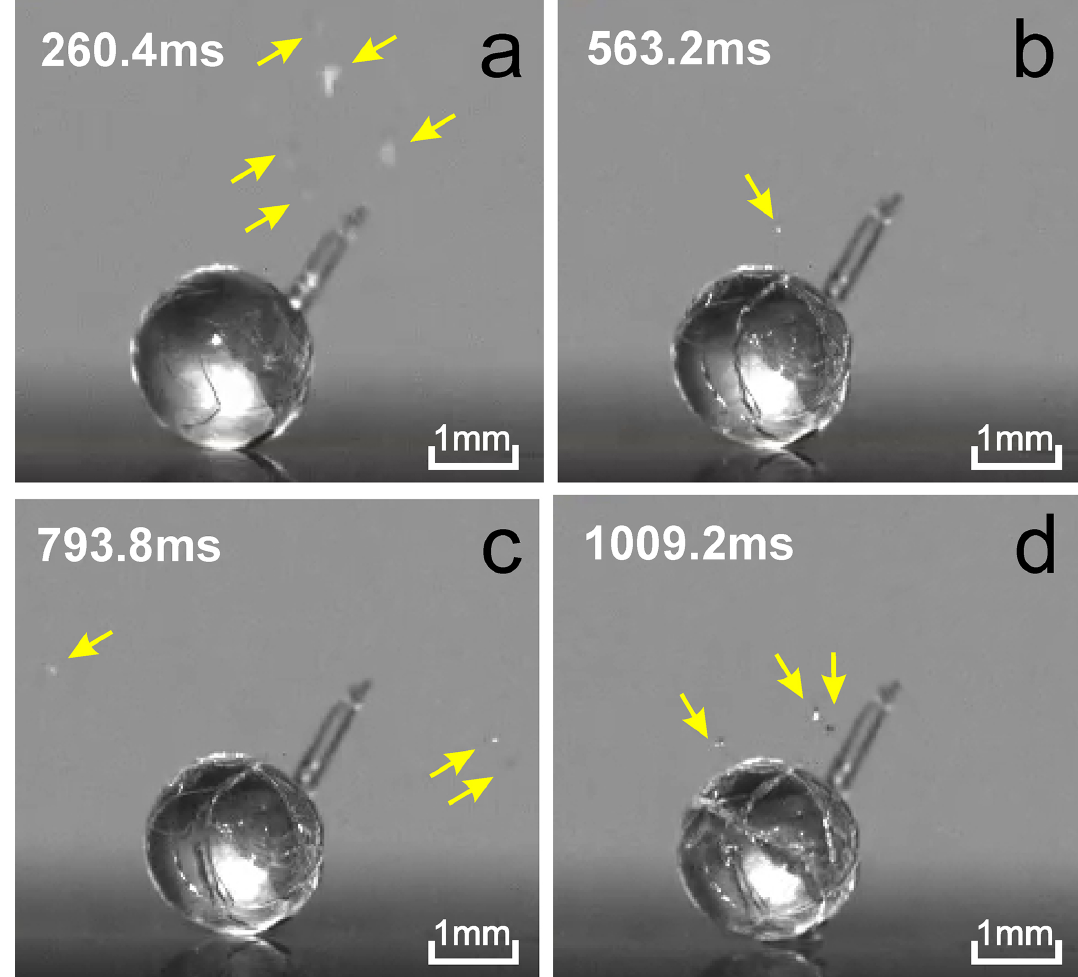
Figure 9. High-speed video snapshots of a 2mm drop at different stages of freezing. The pictures show progressive increase in the number of cracks covering the drop during its freezing. The yellow arrows indicate the locations of ice splinters ejected during cracking. The ambient temperature T = − 7 ◦ C. The numbers in the top left corners indicate time since nucleation. Adapted from video V2 from the supplementary material to Wildeman et al.